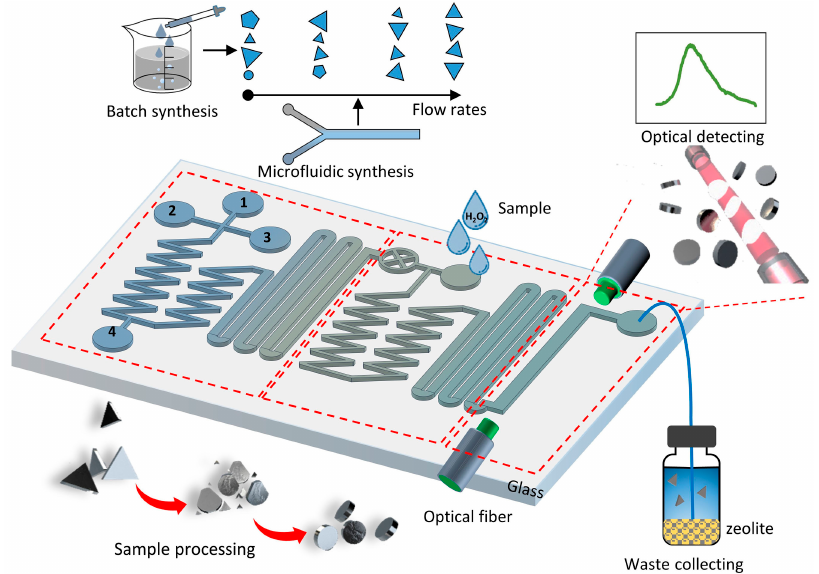
Figure 1. Schematic diagram of the optofluidic system based on Ag-nanoprisms etching for dissolved oxygen (DO) detection. This chip is consisted of three functional part: on-chip synthesis, sample processing, optical detecting. The detecting mechanism is based on the etching process of silver nanoprisms. The blue shift of the SPR peak of Ag nanoprisms can be used for the quantitative analysis of DO.